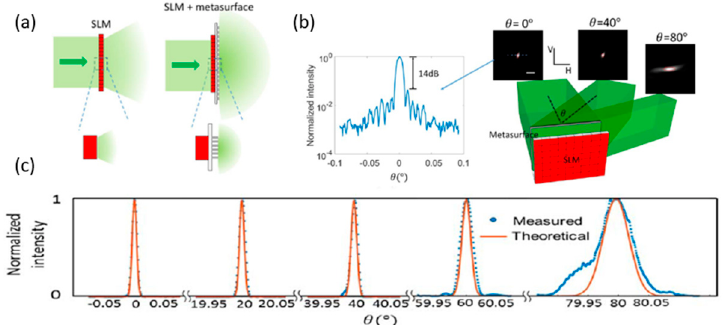
Figure 4. Wide-angular-range and high-resolution beam steering by a metasurface-coupled phased array. ( a ) The comparison of steering range of a single SLM structure and a metasurface-coupled SLM structure. ( left ) without the metasurface, the SLM can provide only a small di ff raction envelope. ( right ) With the metasurface-coupled SLM structure, since each scatterer is subwavelength, the steerable range can span from − 90 ◦ to + 90 ◦ . ( b ) Illustration of the steering scheme ( c ) 1D far − field beam shapes at other steering angles. Red lines denote the theoretical shapes of the beams. Blue dots denote the measured data. (Reproduced from [29] with permission.)